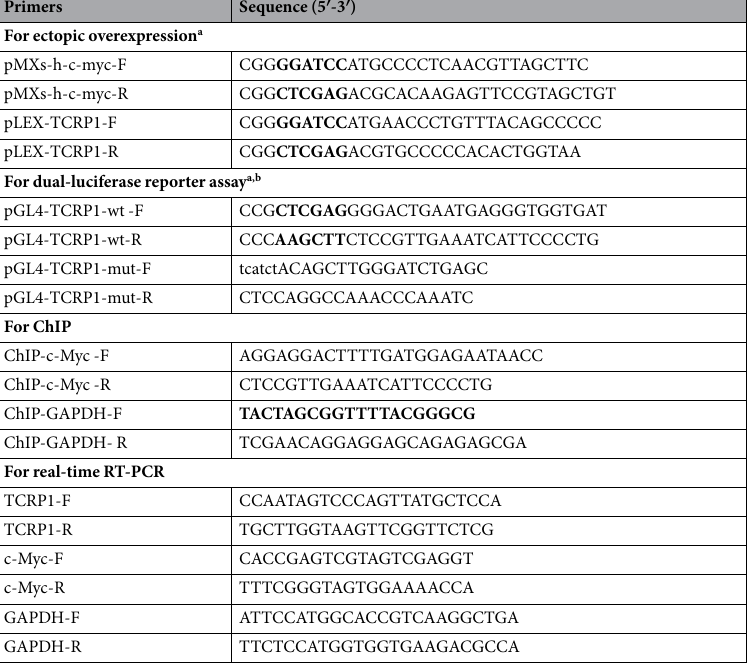
Table 1. Primers list in this study. a Nucleotides under “bold” indicate restriction sites introduced for cloning. b Nucleotides in lower-case are the mutant